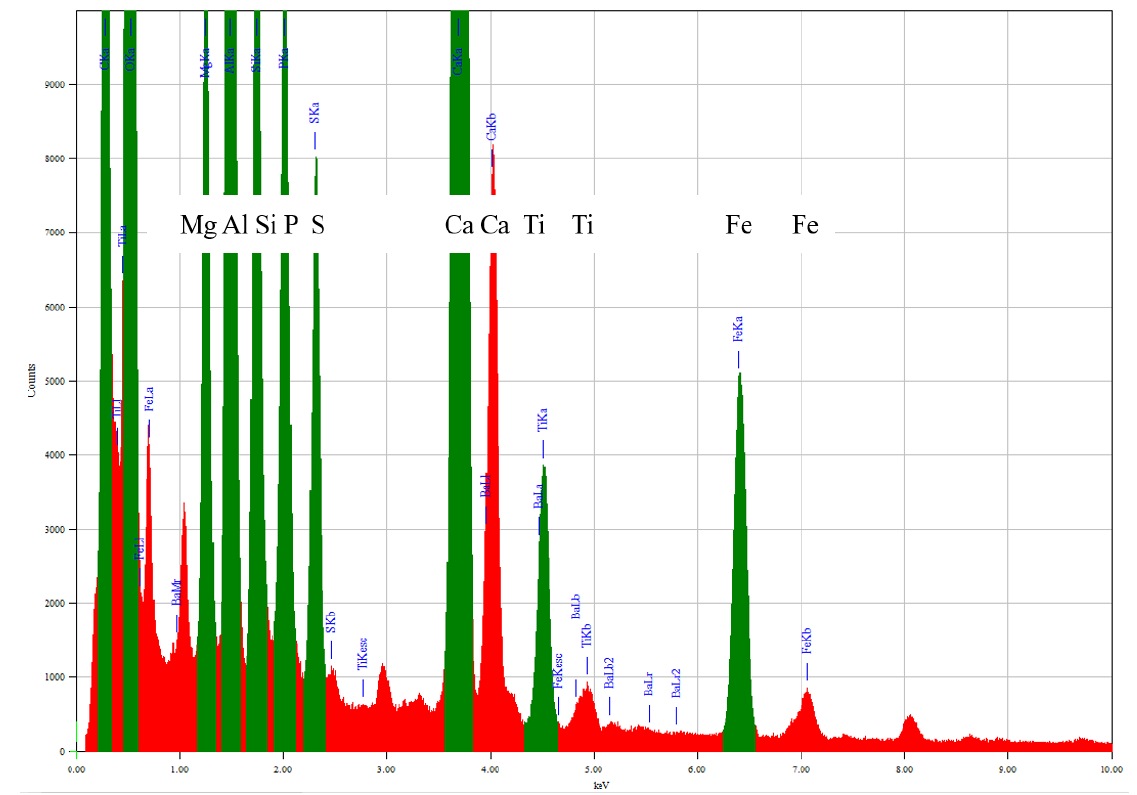
Figure 8. EDS spectrum accompanying Figures 6 and 7. Signals for Au and Pd (not labeled on this figure; see Figures 1 and 2) are extraneous to the sample. The green colored peaks have been used for mapping.